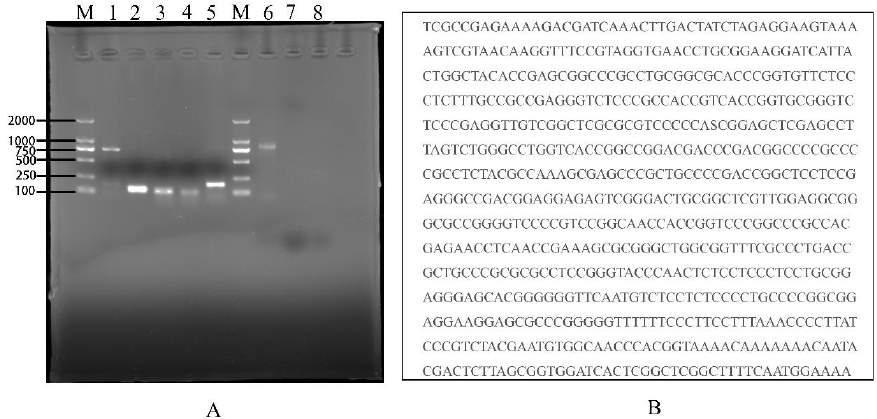
Figure 4. Multi-gene identification and detection of mycoplasma contamination. 18S rRNA amplification and mycoplasma testing ( A ) M: DL2000 DNA marker; Lanes 1: 18S rRNA (691 bp); Lanes 2: β -actin (115 bp); Lanes 3: myoglobin (112 bp); Lanes 4: troponin I (106 bp); Lanes 5: α -actin (184 bp); Lanes 6: Positive control; Lanes 7: Negative control; Lanes 8: TAH-11 cell supernatant; ( B ) sequencing results of the 18S rRNA amplification.